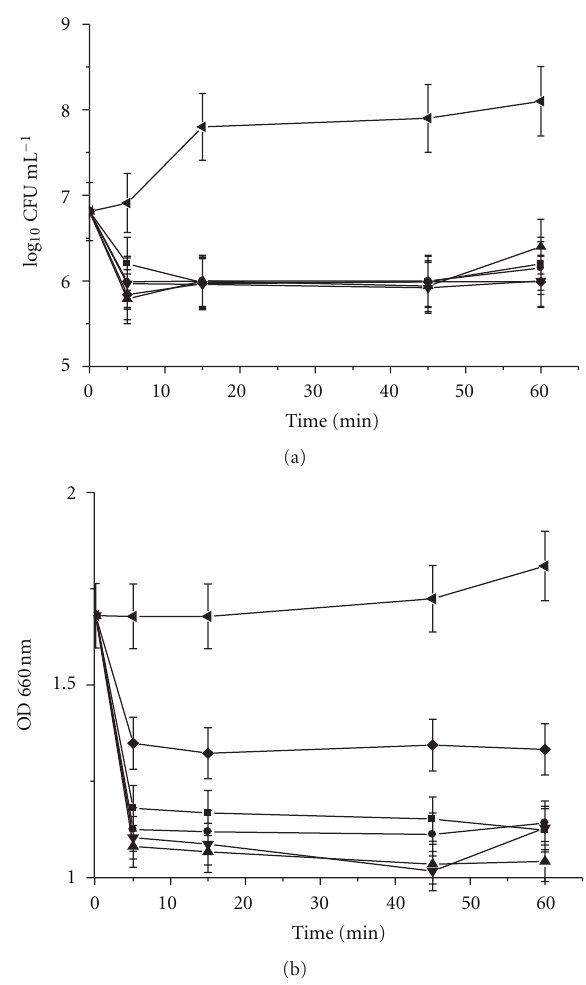
Figure 2: E ff ect of bacteriocins produced by B. thuringiensis on the growth of B. cereus 183. (a) Log 10 cfumL − 1 . (b) Optical density measured at 660nm. The five bacteriocins were added in the middle of the logarithmic phase of growth curve ( ∼ 4 h) of B. cereus (indicator strain) used as control (without bacteriocins). B. cereus 183 ( (cid:6) ); Morricin 269 ( (cid:2) ); Kurstacin 287 ( • ); Kenyacin 404 ( (cid:3) ), Entomocin 420 ( (cid:4) ); Tolworthcin 524 ( (cid:5) ).